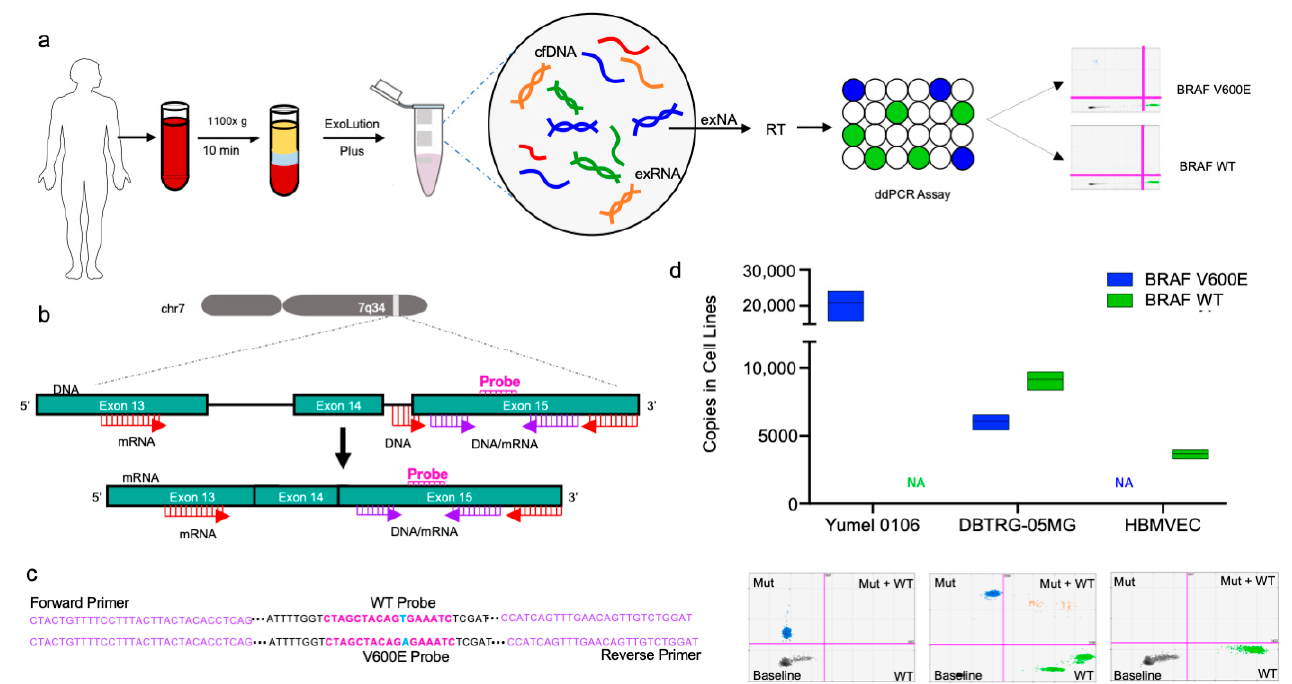
Figure 1. BRAF V600E and BRAF Wild Type ddPCR Assay overview and design. ( a ) Schematic depicting workflow of ddPCR Assay, from blood collection, extraction of exNA using ExoLution Plus Kit (Exosome Diagnostics), reverse transcription, and ddPCR to sample readout; ( b ) Diagram depicting characteristics of primer sets and overall assay design. BRAF DNA primers bind to exon 15 and the adjacent intron. BRAF mRNA primers lie within exon 13. The universal primer set, detects both DNA and mRNA and lies within exon 15. Primer binding sites for DNA and mRNA are indicated in red, while universal primer binding sites are indicated in purple; ( c ) Sequences for the BRAF V600E and BRAF wild type probes (pink), and universal primer sequence (purple) are also denoted. The BRAF V600E point mutation (1700 T>A) is highlighted in blue; ( d ) Absolute quantification of BRAF mutant and BRAF wild type copies ( y -axis) of different cell lines ( x -axis) are graphed. The three cell lines tested, ordered left to right on the graph, were Yumel 0106 (homozygous for BRAF V600E), DBTRG-05MG (heterozygous for BRAF V600E), and HBMVEC (BRAF wild type). ddPCR 2D amplitude plots are shown for each cell line.